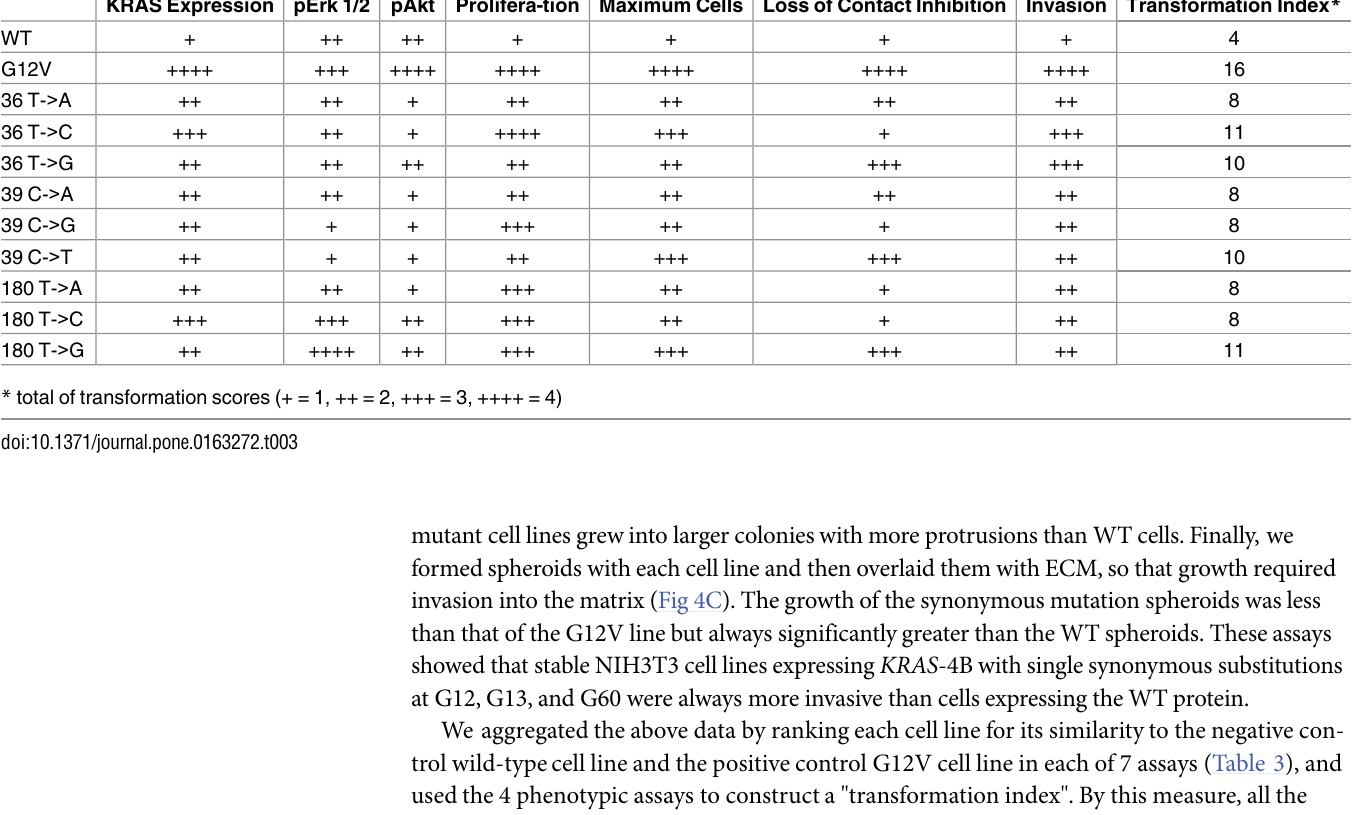
Table 3. Relative scores of cell lines for KRAS expression, signaling by phospho-Erk1/2 and phospho-Akt, and transformation phenotypes. KRAS Expression and